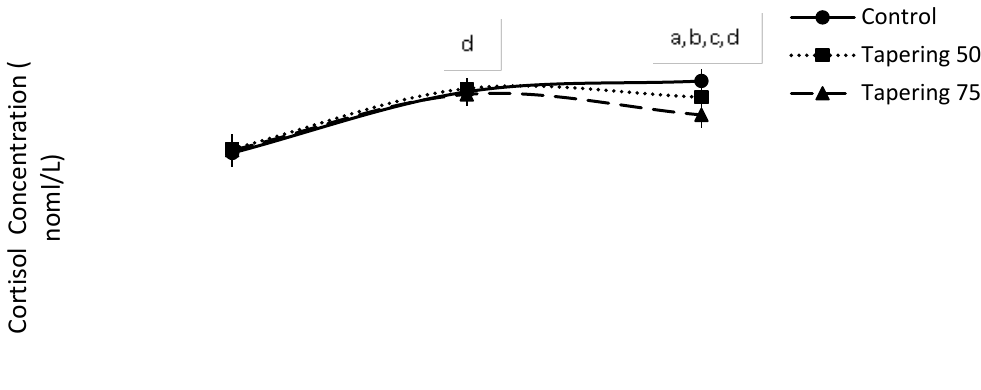
Fig 2: Comparison of the cortisol plasma levels before, after training phase as well as after tapering period in three groups. Significant differences between control and tapering 50%) are indicated with (a) where P<0.05, Significant differences between control and tapering 75% are indicated with (b) where P<0.05, Significant differences between tapering 50% and tapering 75are indicated with (c) where P<0.05, Significant differences from baseline are denoted by (d) where P<0.05. Values are mean ± SD.